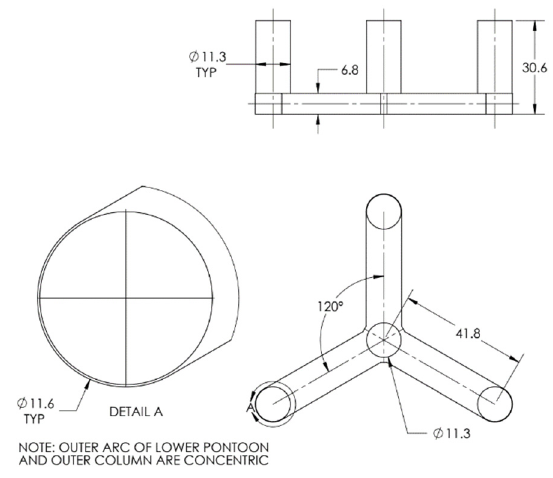
Figure 7. VolturnUS 6-MW Platform Dimensions in Meters.